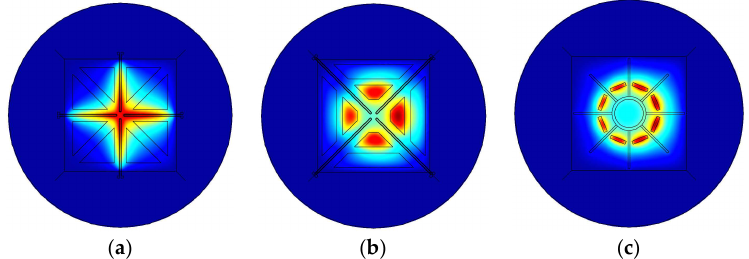
Figure 4. Membrane view ( x – y -plane) of excess temperature of three design alternatives. All devices comprise eight thermistors (two orthogonal arrangements, each comprising four thermistors) and